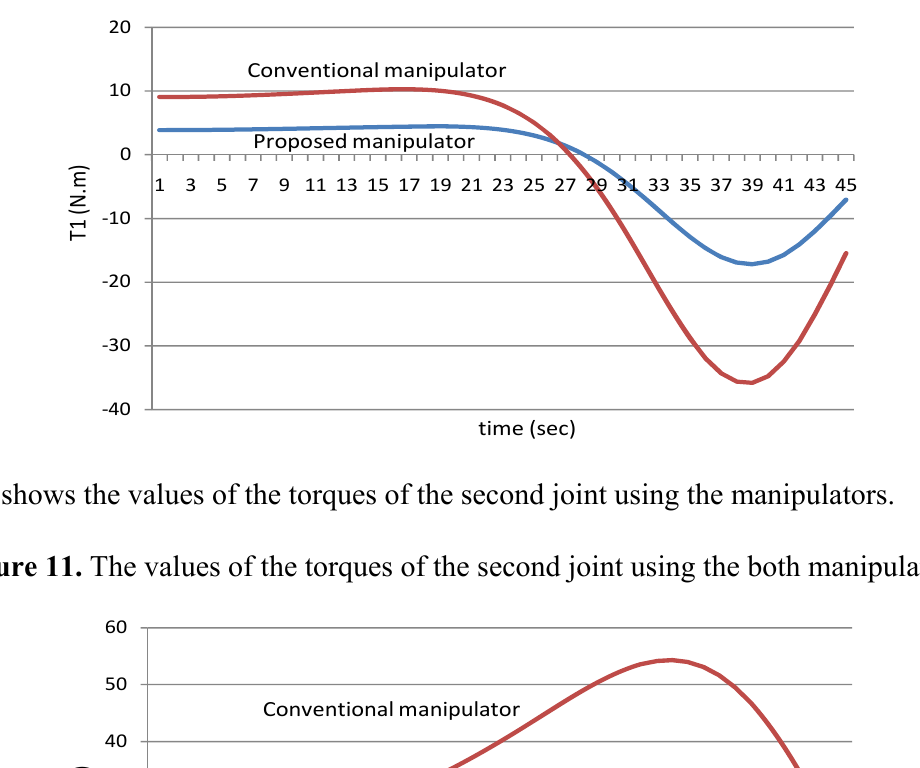
Figure 10. The values of the torques of the first joint using the both manipulators.